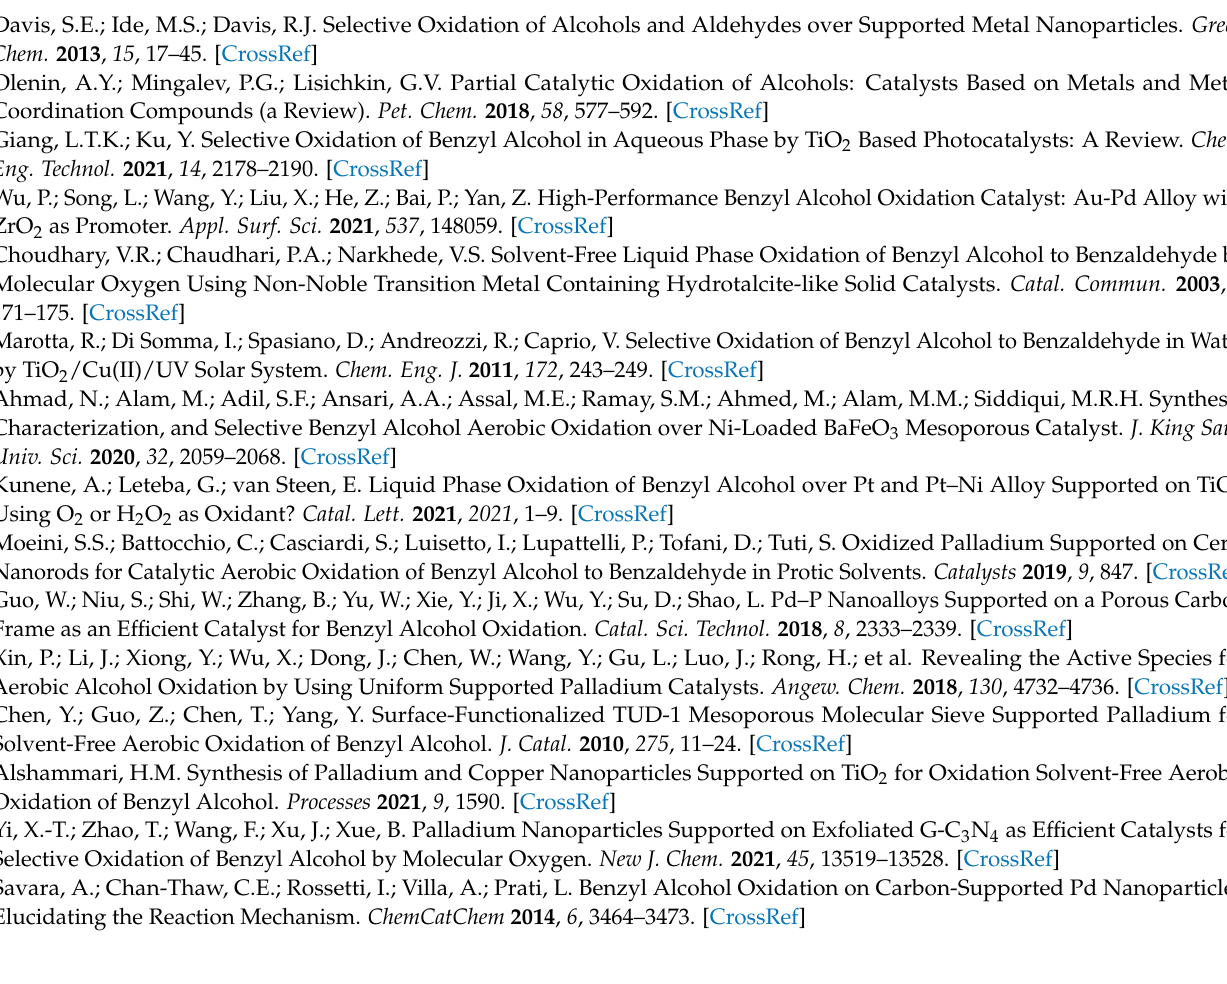
Figure S4: Recyclability of Pd-P/NH 2 -SiO 2 in terms of PhCHO yield. Table S2: Details of calculation of TOF and TOFbulk of Pd-P/NH 2 -SiO 2